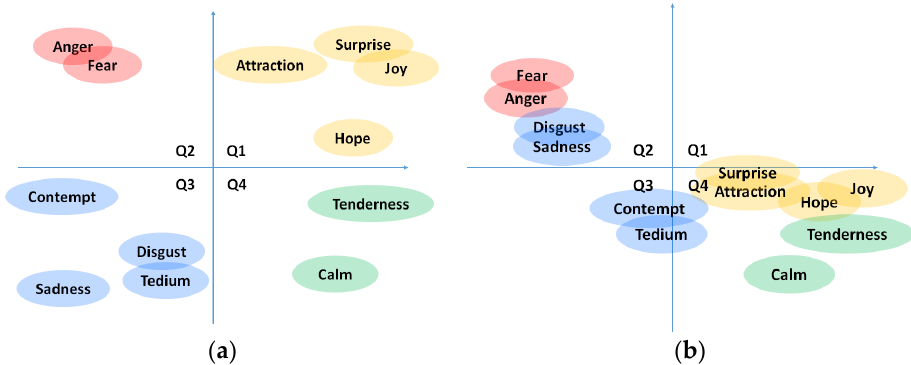
Figure 1. ( a ) Discrete emotion mapping in PA space in the literature. ( b ) Results extracted from Spanish study [28].